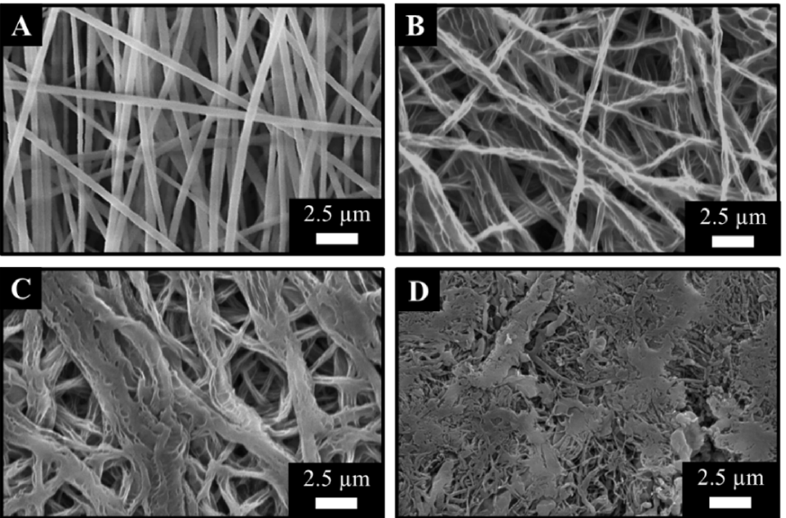
Figure 10. Scanning electron microscopy of hydrogel fibre membranes before ( A ) and after chemical treatment with 25 ( B ), 12.5 ( C ), and 6.25 ( D ) cross-linking degrees.